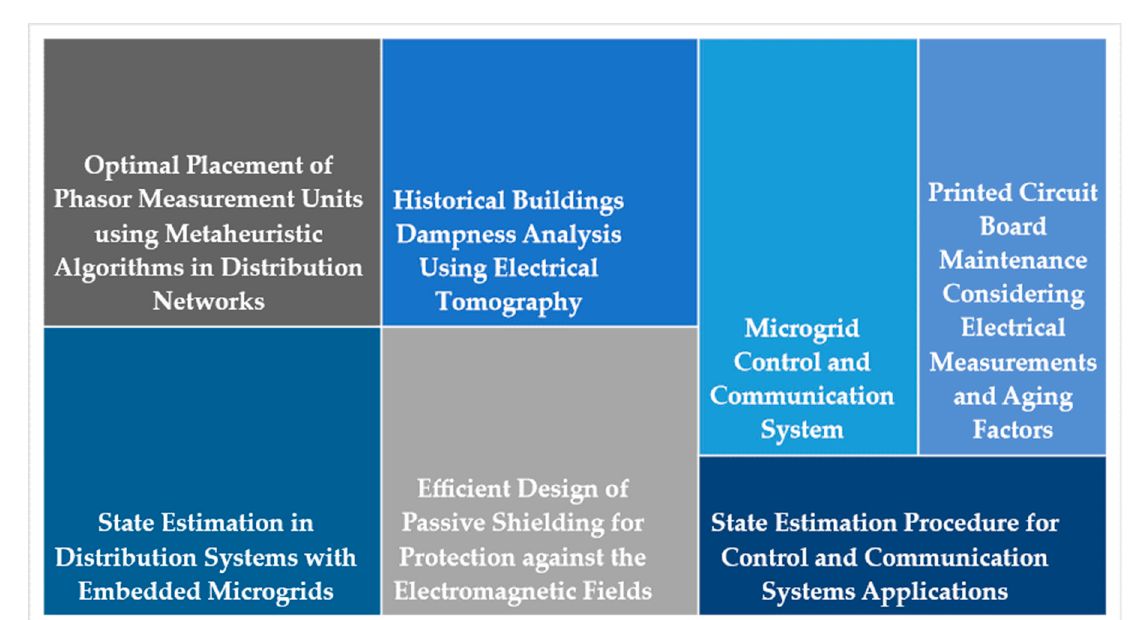
Figure 2. Contribution of each published paper in the Special Issue.